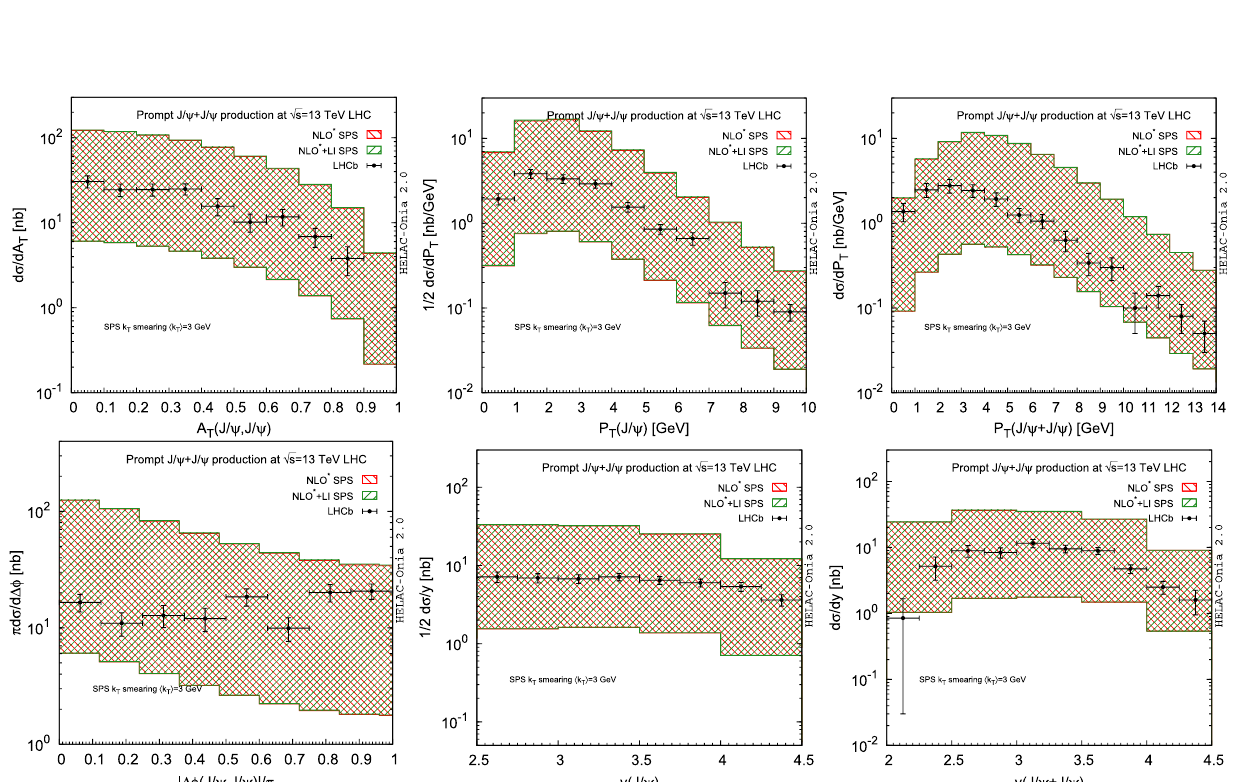
Fig. 13 A T ( J /ψ, J /ψ) (top left), P T ( J /ψ) (top middle), P T ( J /ψ + J /ψ) (top right), Δφ( J /ψ, J /ψ) (bottom left), y ( J /ψ) (bottom middle) and y ( J /ψ + J /ψ) (bottom right) distributions for di- J /ψ production via CS SPS within LHCb